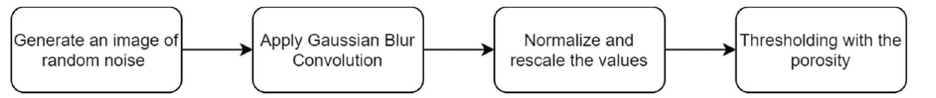
Figure 1. Flowchart of porous media generation process with corresponding sub-processes.